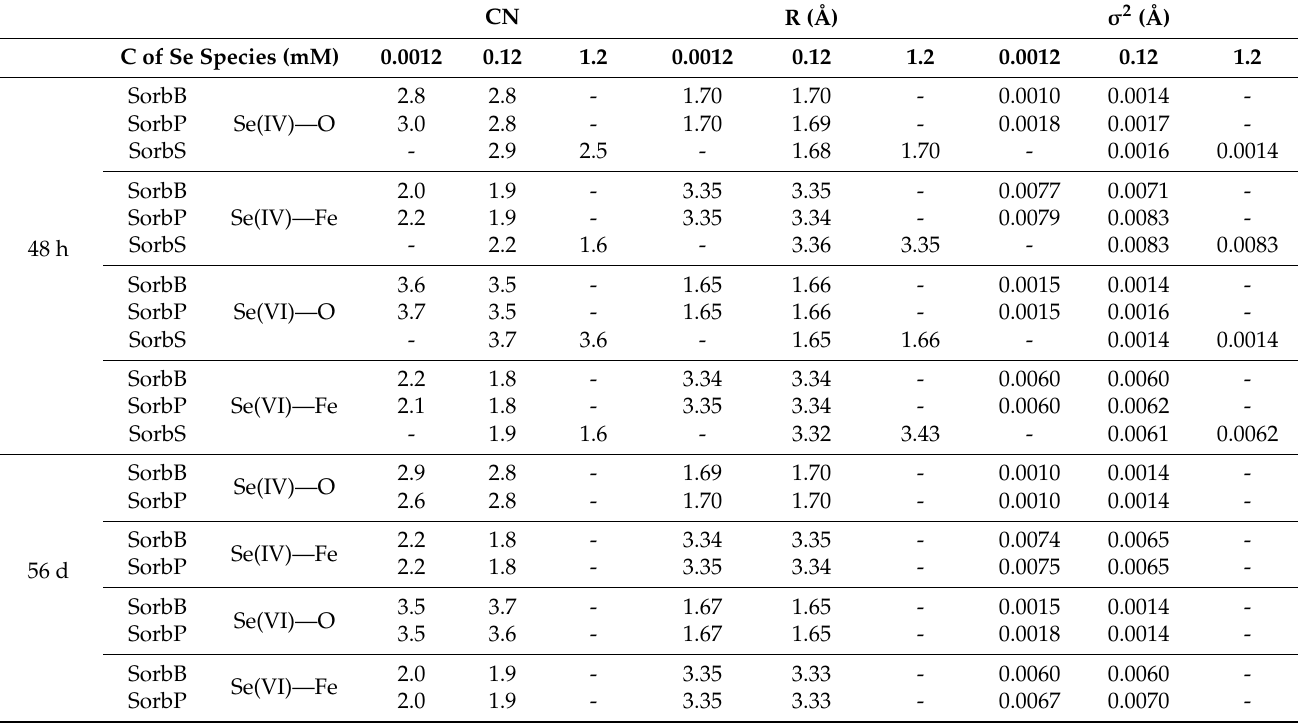
Figure 4. Normalized k 3 -weighted Se K-edge EXAFS spectra (left) and RSF profiles of EXAFS spectra (right) of Se(IV) and Se(VI) adsorbed onto ( a ) SorbS (1 g/L) at initial Se concentration of 0.12 and 1.2 mM after 48 h, and ( b ) SorbB and SorbP (1 g/L) at initial Se concentration of 0.0012 and 0.12 mM after 48 h and 56 d at pH 3. Table 2. Structural parameters of Se(IV) and Se(VI) adsorbed on SorbB, SorbP and SorbS from single-species experiments at initial Se concentrations of 0.0012, 0.12 and 1.2 mM after 48 h and 56 d derived from EXAFS spectrum